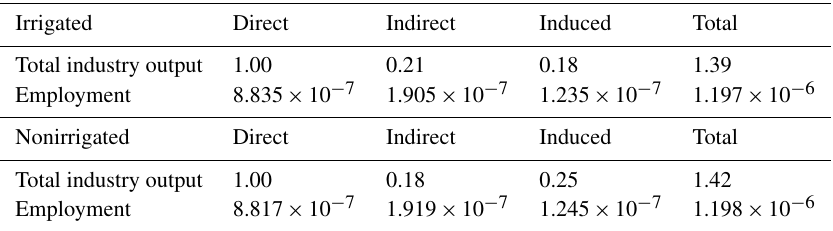
Table A1. IMPLAN multiplier for crops in western